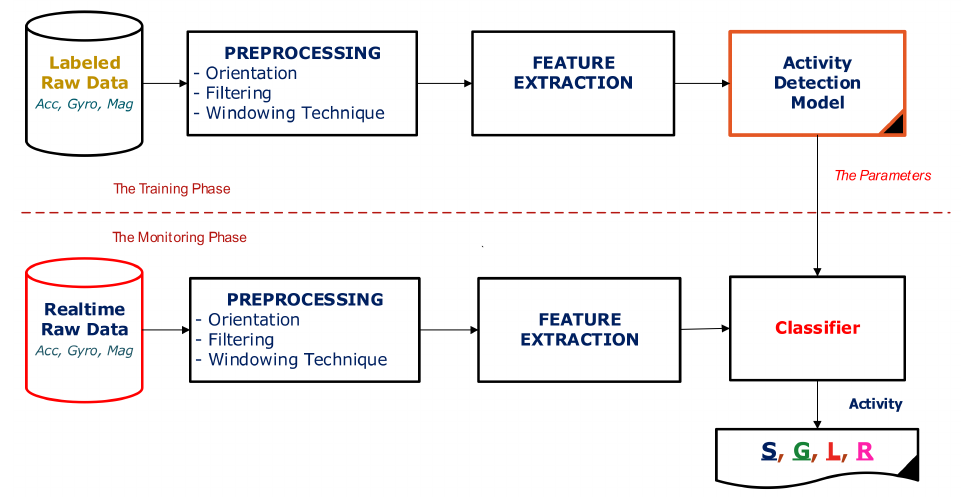
Figure 3. The framework of the Activity Detection Module